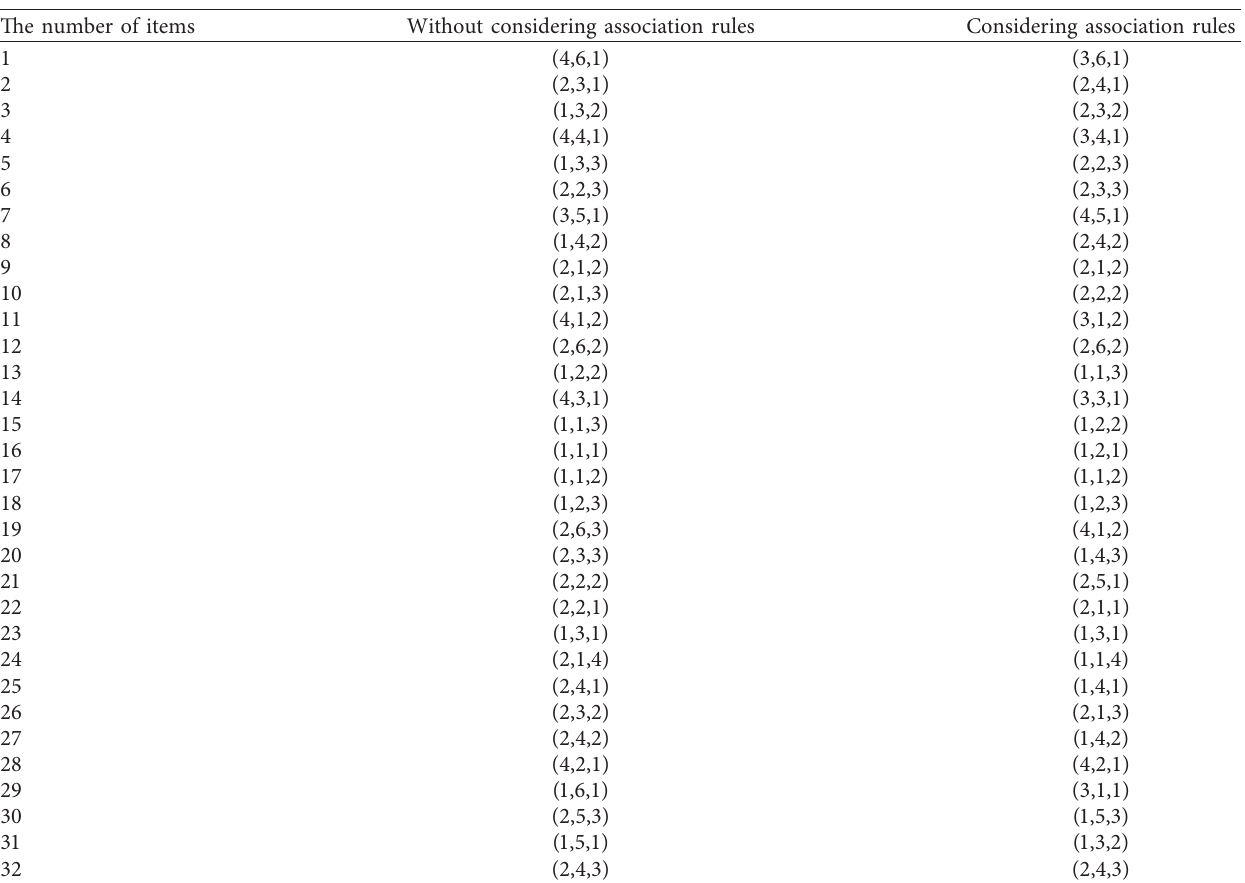
Figure 6: (a) The optimized cargo position stereogram. (b) Algorithm comparison iteration diagram. Table 2: Data of